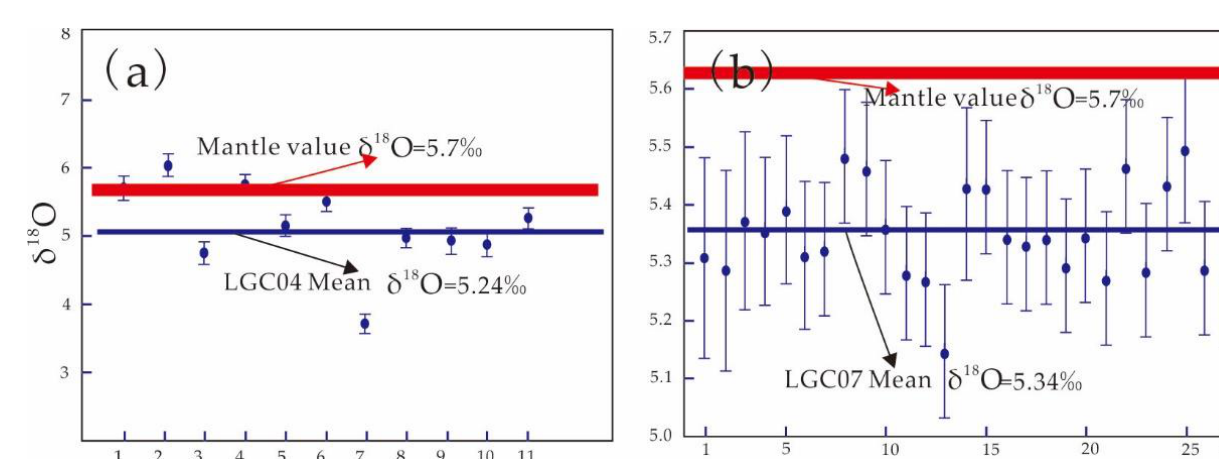
Figure 8. ( a,b ) The SIMS oxygen isotope results of gabbro. Figure 8. ( a , b ) The SIMS oxygen isotope results of